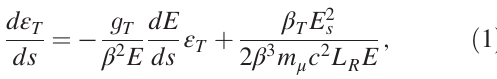
; g can be modified but T L ¼ 1 − T